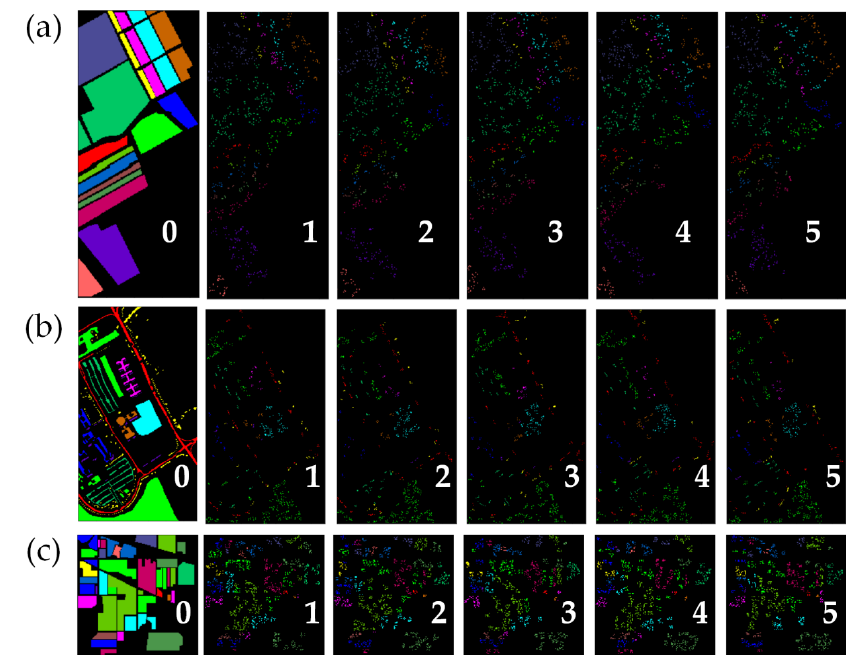
Figure 7. Training pixels in ( a ) Salinas Valley dataset, ( b ) Pavia University dataset, ( c ) Indian Pines dataset. Subfigure 0 in each dataset is the ground truth for the corresponding dataset. The other subfigures represent the training pixels for different